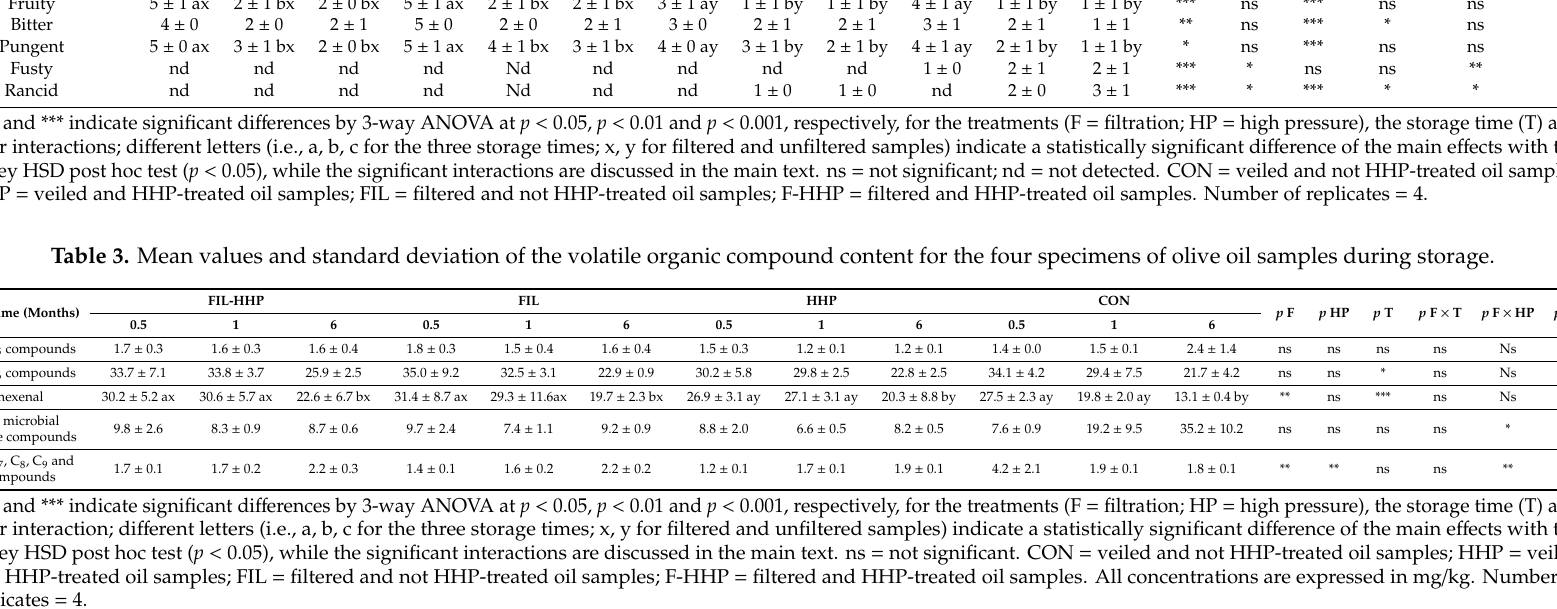
Table 2. Mean values and standard deviation of the panel test sensory attributes for the four specimens of olive oil samples during storage. Storage Time (Months) Fruity